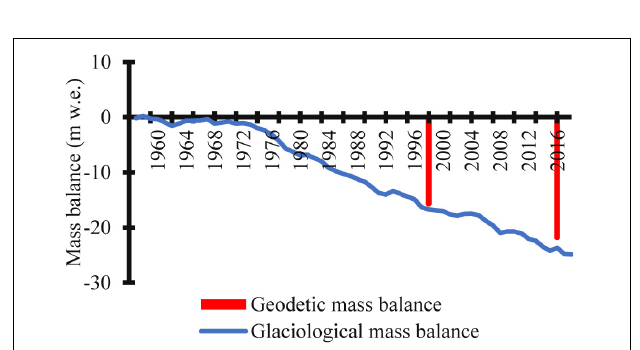
FIGURE 8 | Cumulative glaciological and geodetic mass balances of the Central Tuyuksu